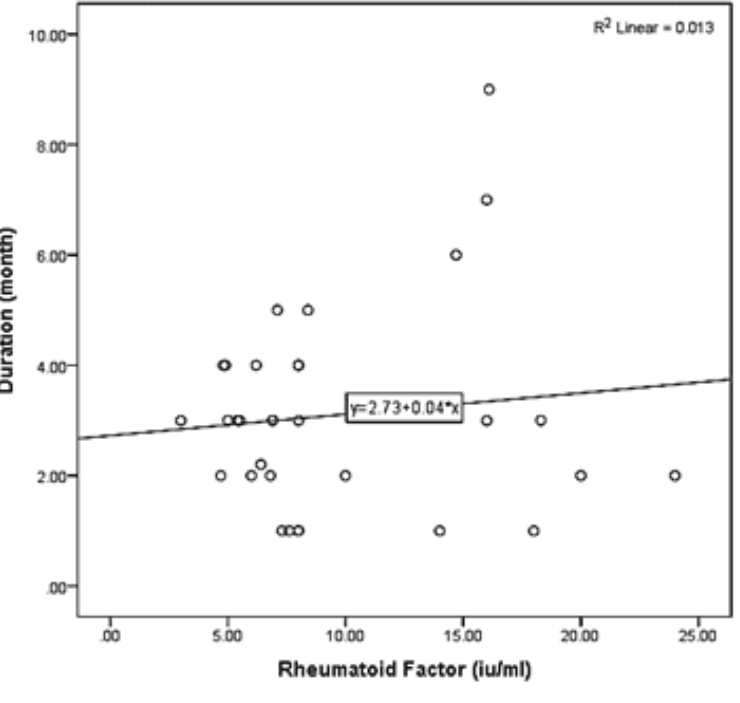
Figure 2: Relationship between rheumatoid factor and the duration of CHIKV